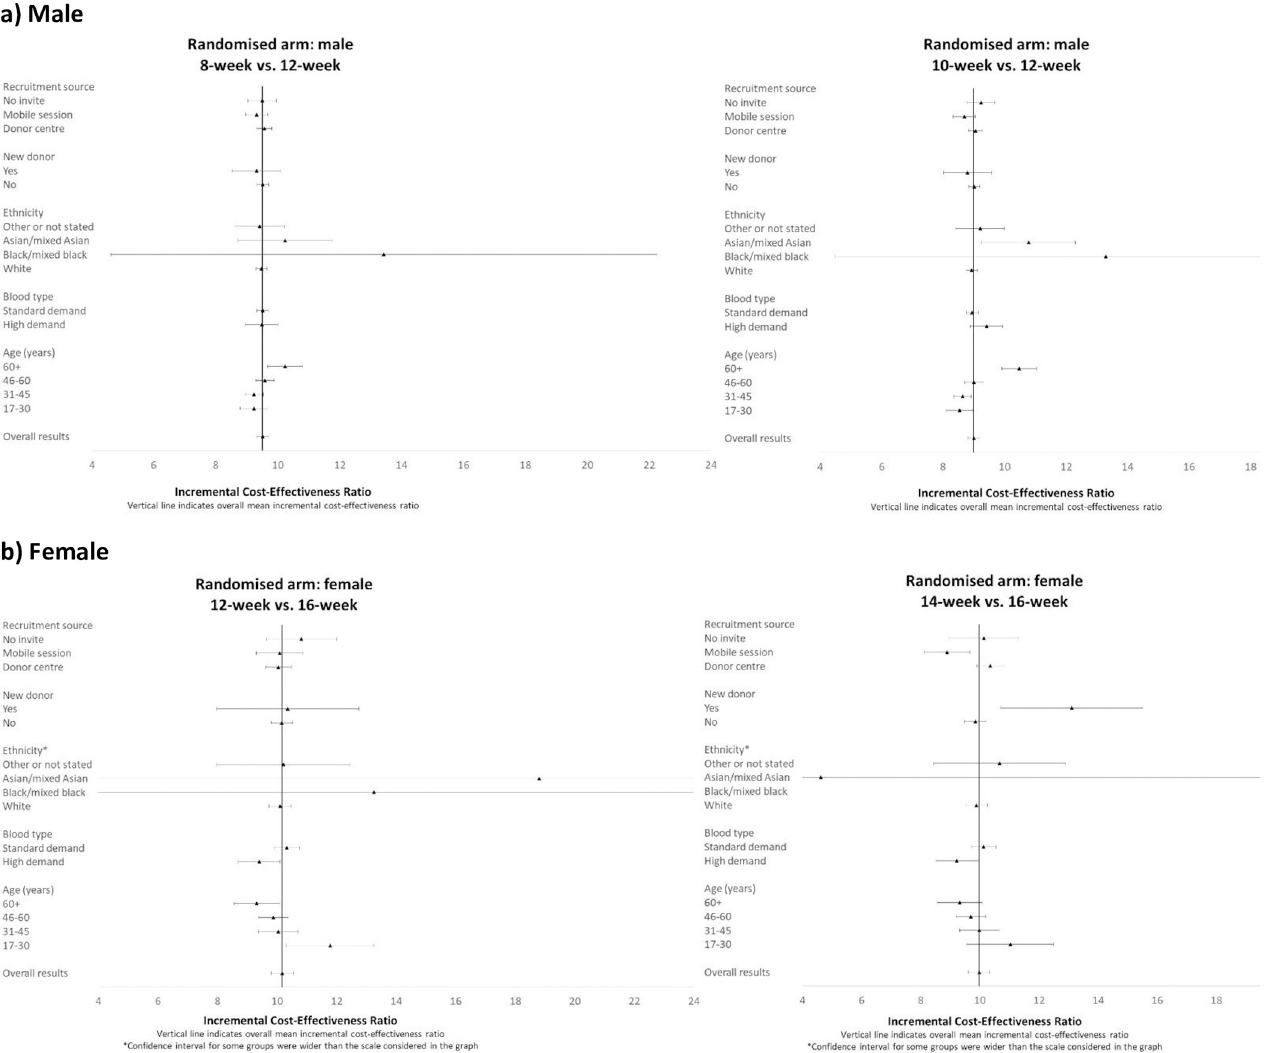
Fig 3. Mean (95% CI) incremental cost-effectiveness ratios over two-year follow-up period by subgroup. a) Male b) Female.